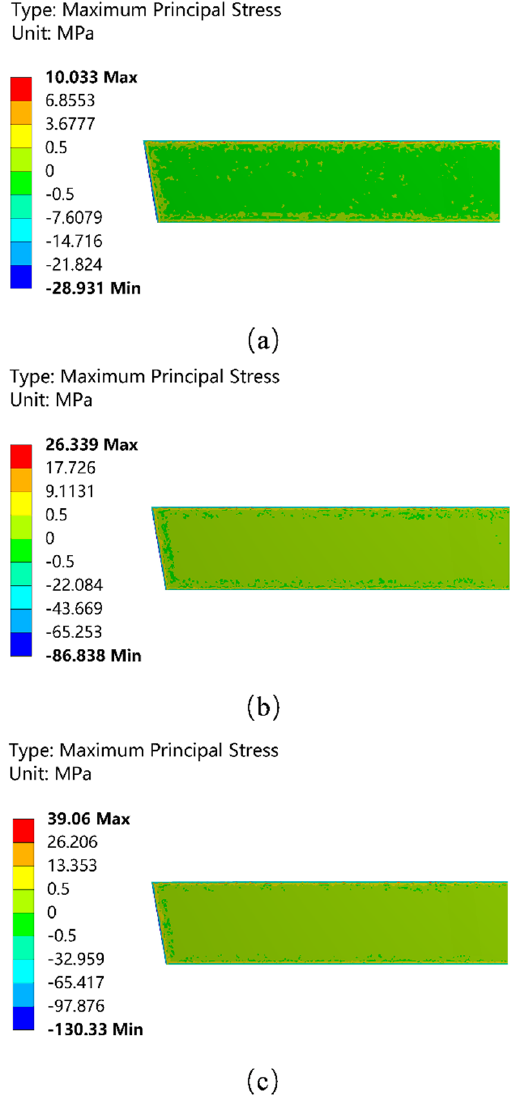
Figure 4. Distribution of the maximum principal equivalent stress field of the working layer. ( a ) The first stage of preheating; ( b ) the second stage of preheating; and ( c ) the third stage of preheat ‐ ing.